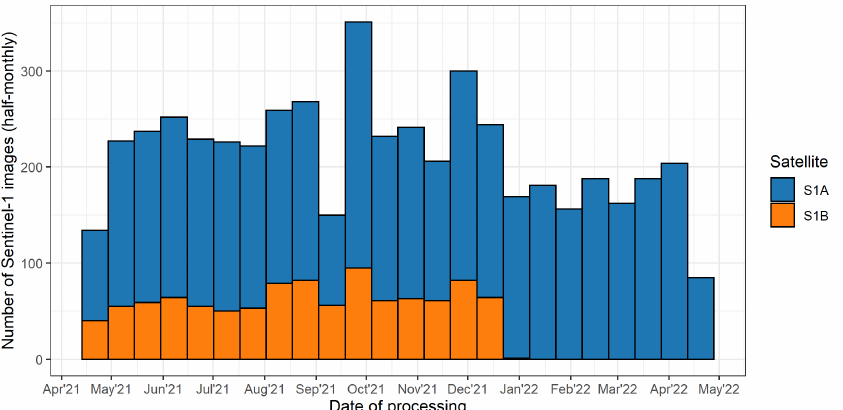
Figure 2. Cadence of images processing by the DETER-R system over its first operational year, illustrating the two main incidents affecting S1 images delivery by ESA: production gap in September 2021 and the stop of Sentinel-1B image production in January